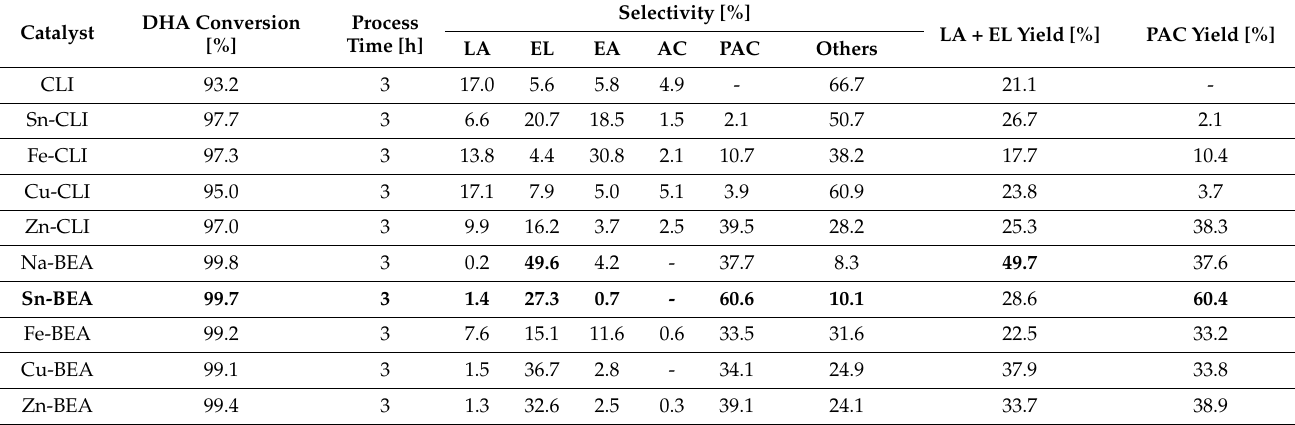
Table 3. The results of the GC analysis and carbon balance for the catalytic conversion of DHA in the liquid phase: (a) after three hours of the process, and (b) after five hours of process. LA—lactic acid, EL—ethyl lactate, EA—ethyl acetate, AC—acetic acid, PAC—pyruvic aldehyde, PAL—pyruvaldehyde. The others are mixtures of LA, EL and unreacted DHA.